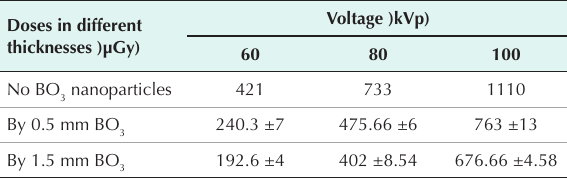
Table 2. The Effect of Shielding Thickness at Different Voltages )5) Doses in different thicknesses )µGy)